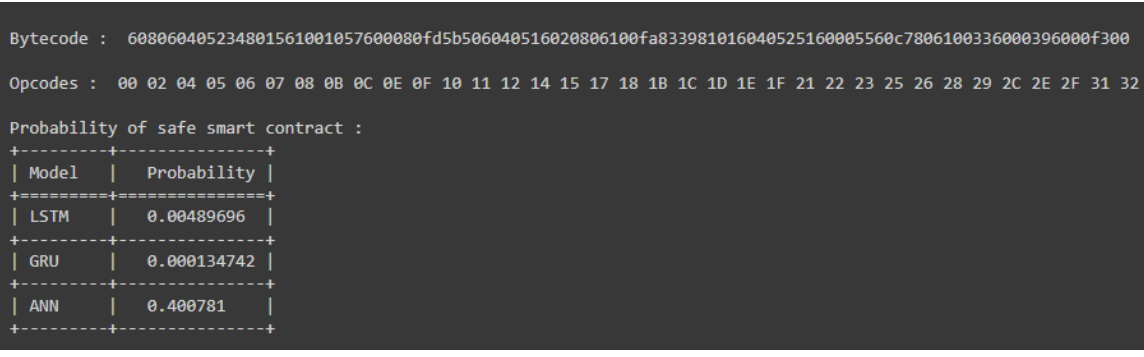
Figure 3. Probability of a smart contract being vulnerable by ANN, GRU, and